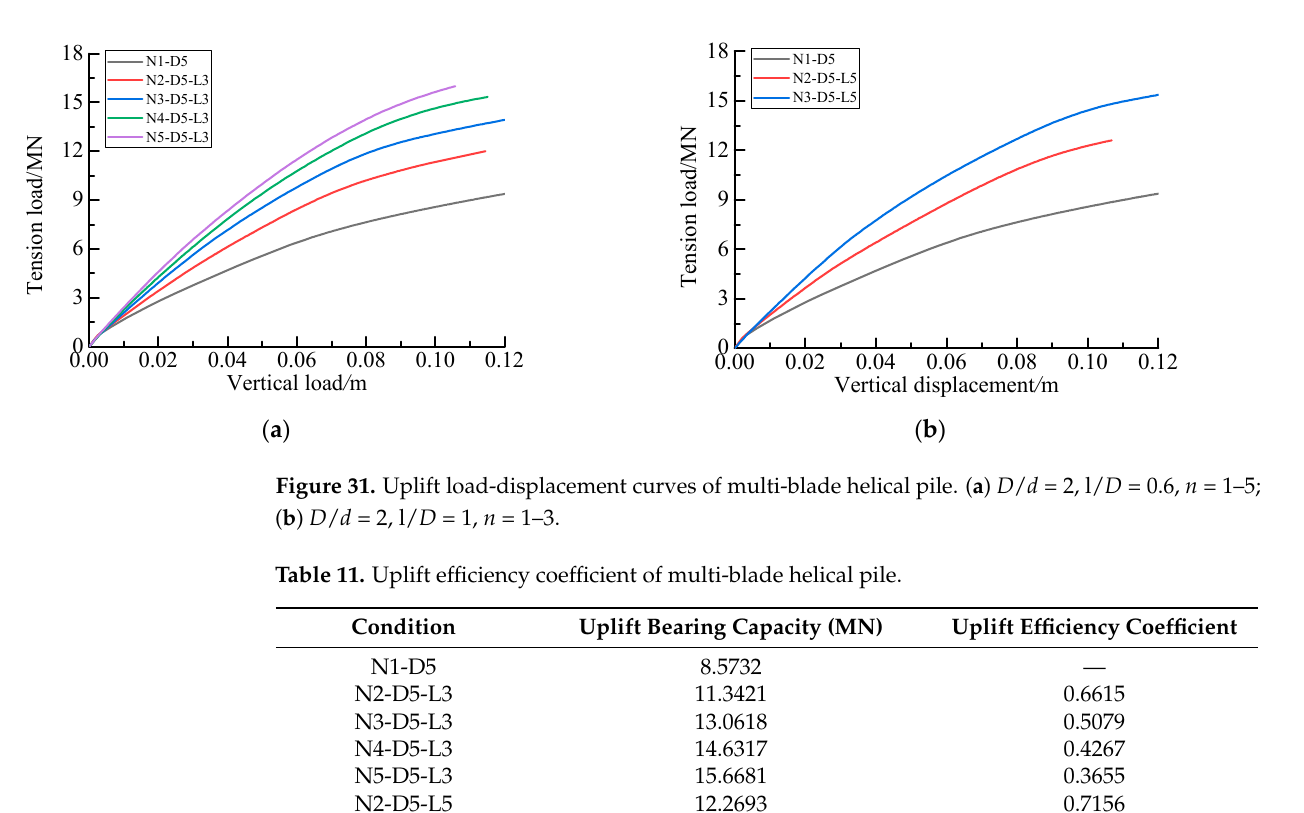
Table 11. Uplift efficiency coefficient of multi-blade helical pile. Condition